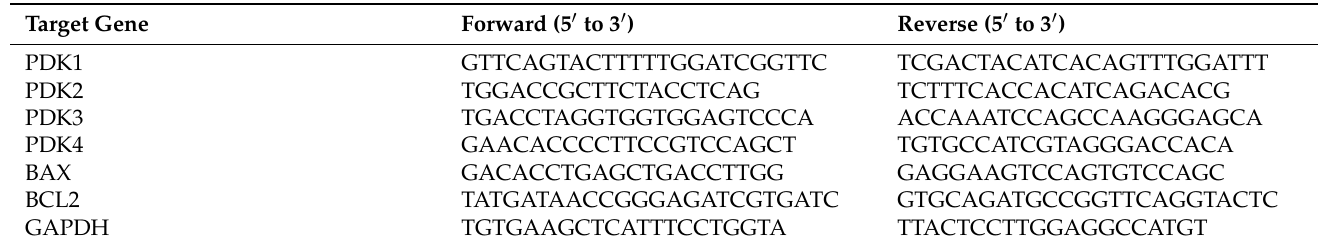
Table 2. Polymerase chain reaction (PCR) primer